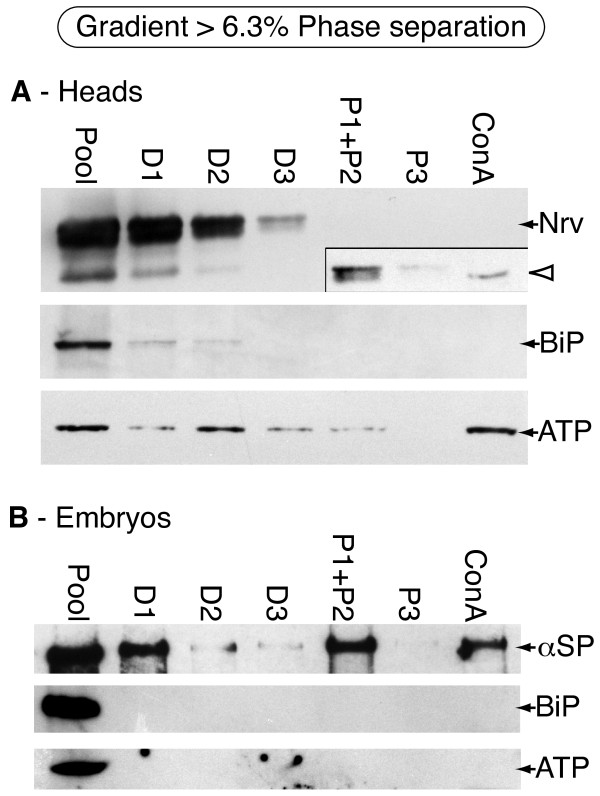
Immunoblot analysis of samples fractionated by density gradient centrifugation followed by two phase affinity partitioning using 6.3%PEG/Dextran. A - Fractionation of microsomes prepared from heads. Most Nervana is left behind in the dextran fractions, although a 60× exposure shows that a low yield of Nervana is found in the eluted ConA fraction (arrowhead in inset). BiP is no longer detectable in this combined preparation, demonstrating the utility of pre-fractionation on an Optiprep gradient. Residual ATP synthase is detected in the eluted fraction. Labels: Pool - pooled fractions 15-20 from the initial Optiprep gradient. Other labels are as described in figure 2A. Loading: Equivalent amounts of all fractions were loaded. Detection: normal sensitivity chemiluminescence (Nrv), high sensitivity chemiluminescence (BiP, ATP synthase). B - Fractionation of microsomes prepared from 0-15 hr embryos. Some α-Spectrin is recovered in the eluted fraction although some seems to have partitioned into dextran phase D1 and some has been excluded from the ConA as seen in the PEG phase (P1+P2). Neither BiP, nor ATP synthase is detectable in the eluted ConA fraction. Labels: same as A. Loading: Equivalent amounts of all fractions were loaded. Detection: high sensitivity chemiluminescence (α-Spectrin, BiP and ATP synthase). N.B. 'high' sensitivity detection reagents are 100-1000× more sensitive than the 'normal' sensitivity substrates and were used to detect even low-level residual contamination.